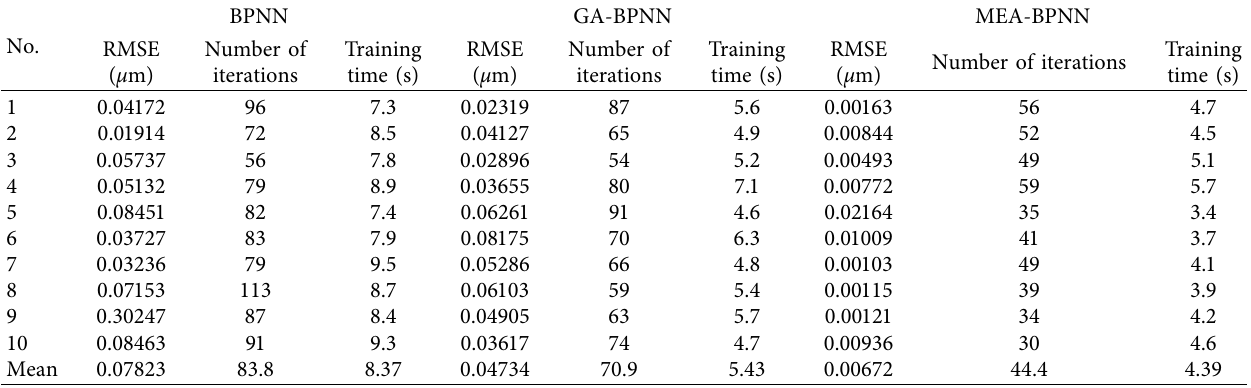
Table 5: Data for model diagnostic